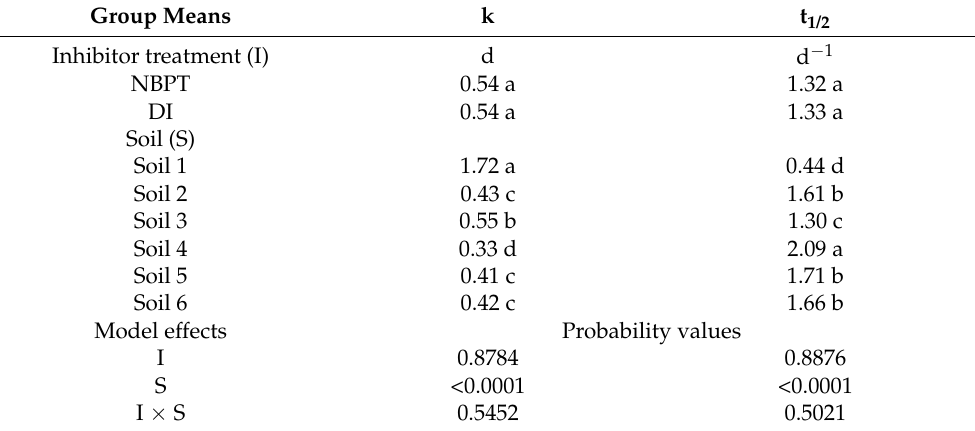
Table 3. Effect of inhibitor treatment and soil on degradation rate constant (k) and half-life (t 1/2 ) of